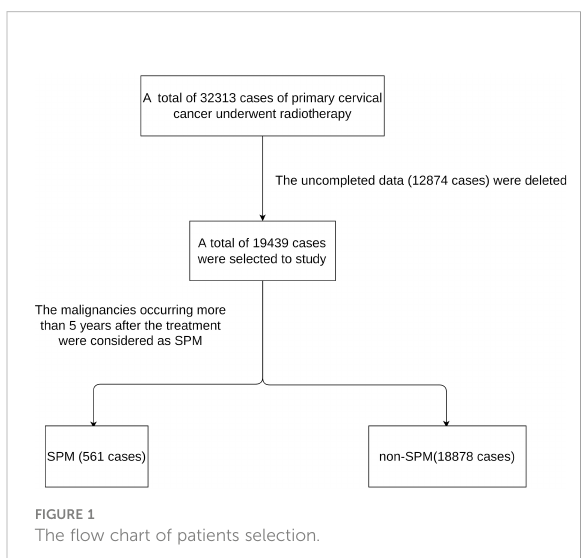
FIGURE 1 The fl ow chart of patients